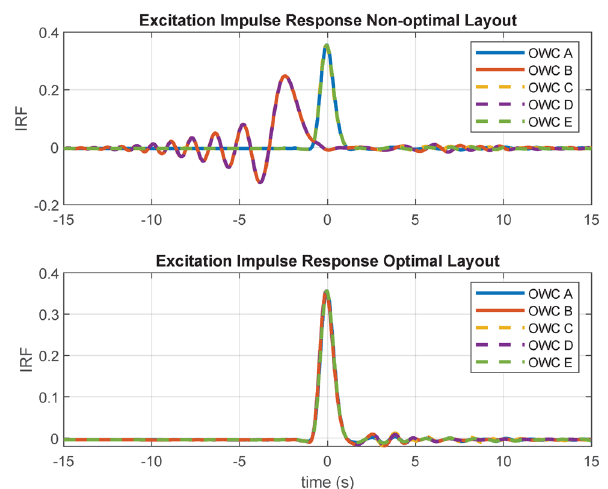
Fig. 5. Heave excitation impulse response for each body in the non-optimal and optimal array configuration.